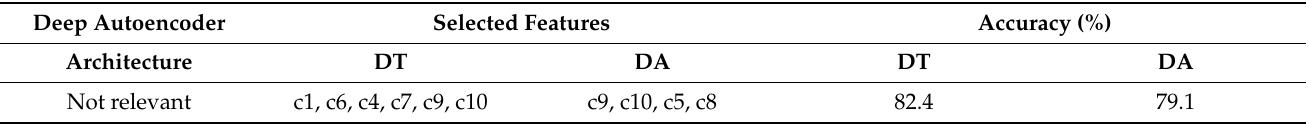
Table 1. Selected standard features in order of importance and corresponding classification accuracy for DT and DA classifiers.